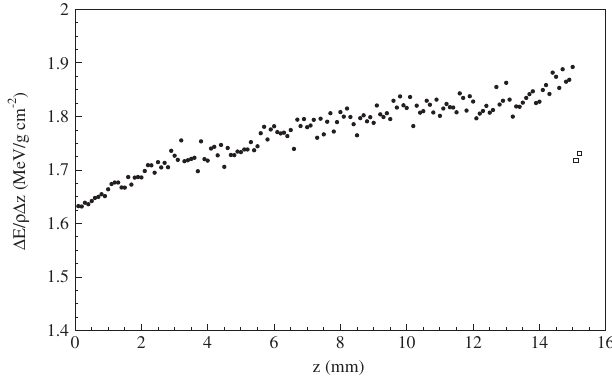
FIG. 21. Energy deposited by a 1.5 TeV undisrupted beam (in MeV = g cm (cid:1) 2 ) along the exit window: the last two points corre- spond to the thin aluminum